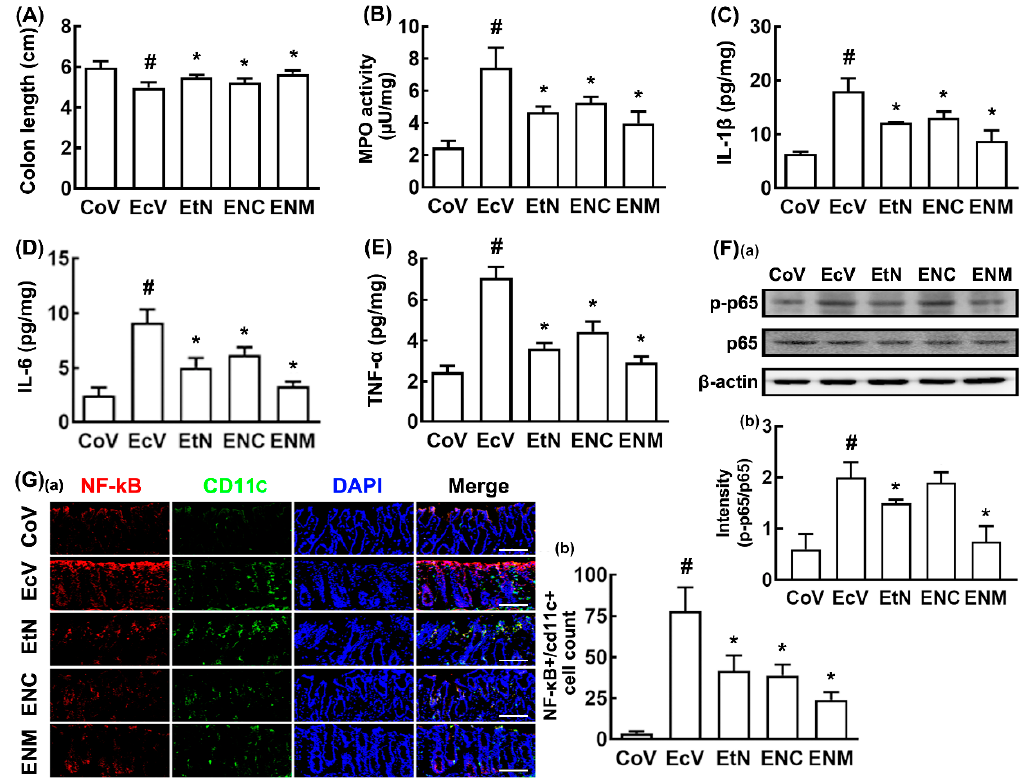
Figure 6. NK109 and its lysates alleviated K1-induced colitis in the mice. Effects on the colon length ( A ), myeloperoxidase (MPO) activity ( B ), IL-1 β ( C ), IL-6 ( D ), TNF- α expression ( E ), NF- κ B activation (( F ): ( a ) Immunoblotting photo; ( b ) their intensities), and the NF- κ B + /CD11c + cell population (( G ): ( a ) Confocal microscope photo; ( b ), their intensities) in the colon. The mice of the EcV, EtN, ENC, and ENM groups were exposed to K1 (1 × 10 9 CFUs/mouse/day) daily for 5 days and thereafter treated with the test agents (EcV, vehicle; EtN, 1 × 10 9 CFUs/mouse/day of tNK109; ENC, supernatant fraction (NC) of NK109 (1 × 10 9 CFUs) lysate/mouse/day; ENM, precipitate fraction (NM) of NK109 (1 × 10 9 CFUs) lysate/mouse/day) daily for 5 days. The control group (CoV) was treated with the vehicle instead of K1 and NK109. Data values are described as mean ± SD ( n = 6). # p < 0.05 vs. CoV. * p < 0.05 vs. EcV.